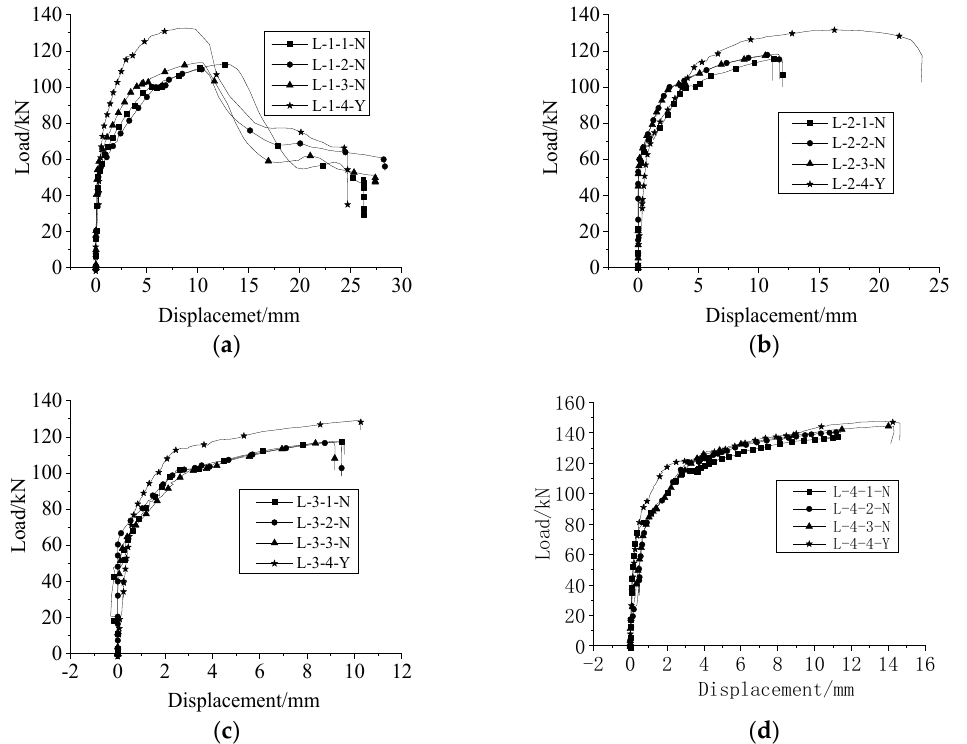
Figure 14. Load–displacement curves under uniaxial tension. ( a ) Group L − 1, ( b ) Group L − 2, ( c ) Group L − 3, ( d ) Group L −